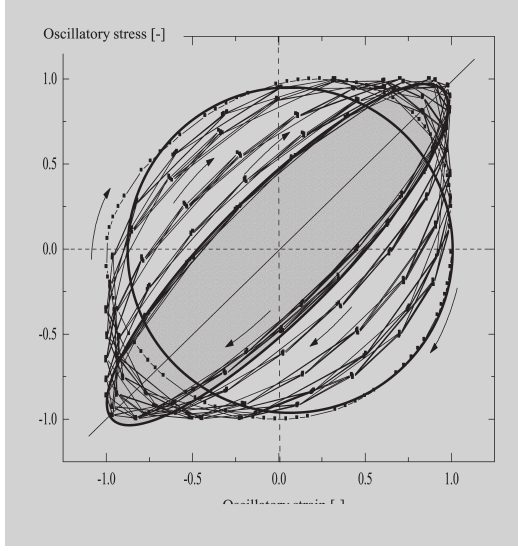
Figure 11: Experimental non-dimensional Lissajous figure for sample